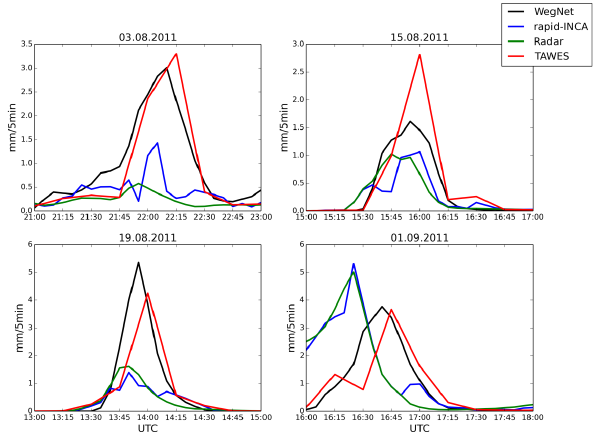
Figure 7. Temporal evolution of precipitation rates for WegenerNet (WegNet), rapid-INCA, radar derived QPE (Radar), and TAWES station and four selected